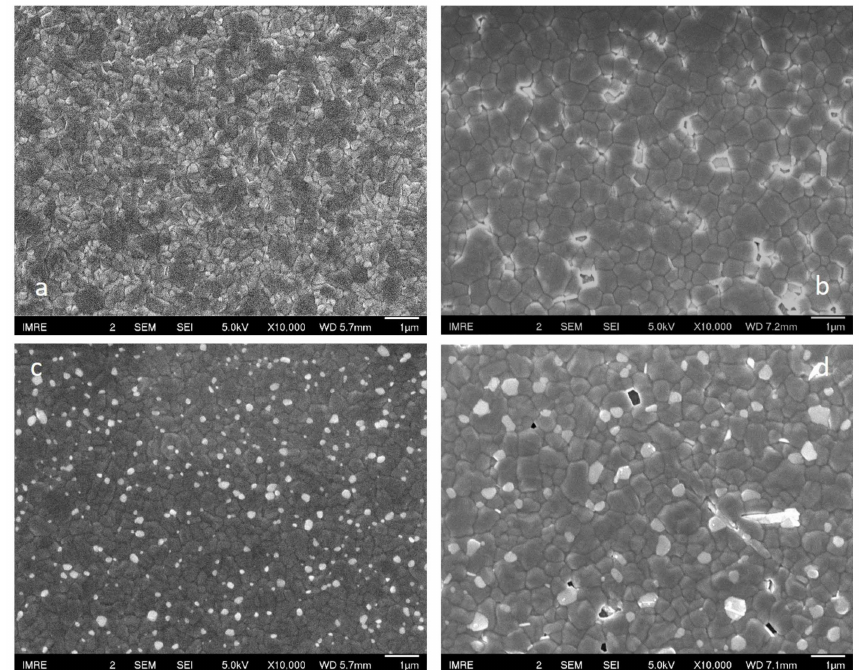
Figure 5. SEM images of MAPbI 3 and FAPbI 3 samples before and after water vapor exposure for 2 h. ( a ) Pristine MAPbI 3 sample; ( b ) MAPbI 3 sample after degradation; ( c ) pristine FAPbI 3 sample; ( d ) FAPbI 3 sample after